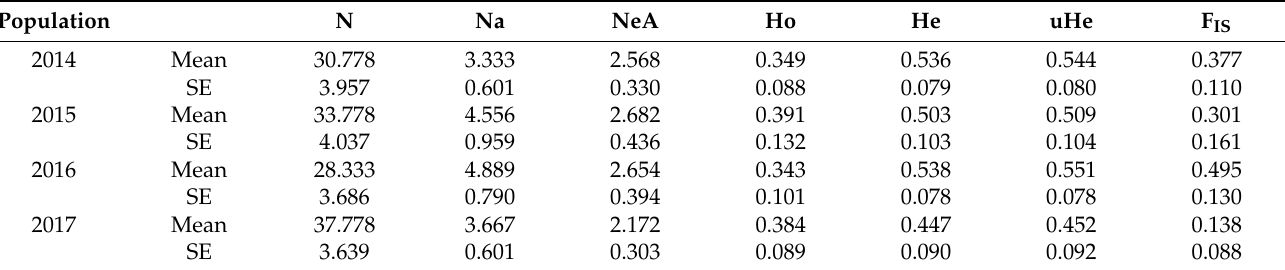
Table 2. Genetic diversity of each snail population.